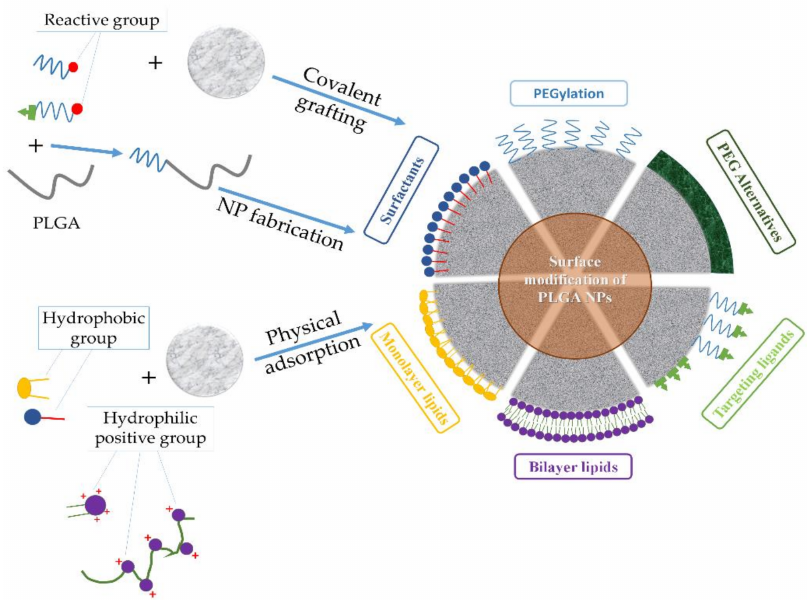
Figure 3. Different strategies used in the surface modification of PLGA NPs. Table 3. Overview of materials used for coating the PLGA